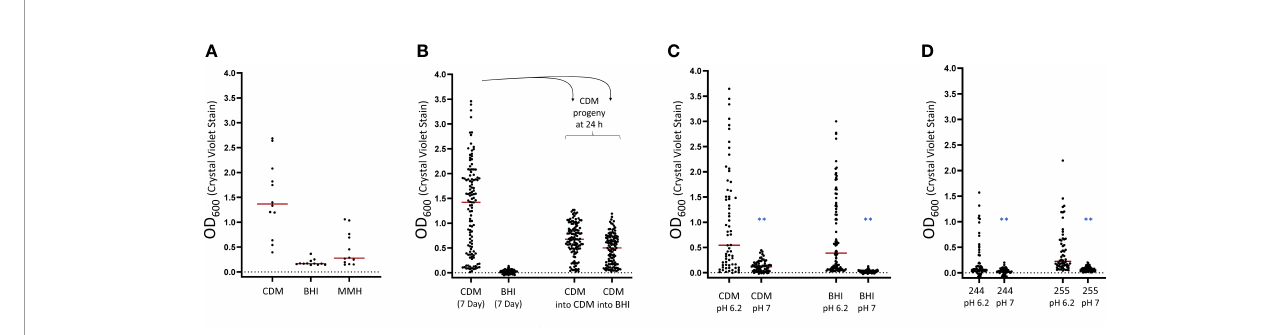
FIGURE 4 | pH of the culture medium impacts the ability of F. tularensis to form bio fi lm. (A) LVS bio fi lm formation was assessed in Chamberlain ’ s de fi ned medium (CDM), brain-heart infusion broth (BHI) supplemented with 1% IsoVitaleX and modi fi ed Mueller-Hinton broth (MMH) supplemented with 2% IsoVitaleX. Bio fi lms were assayed at 10 days post-inoculation. (B) LVS grown in either CDM or BHI for 7 days was sub-cultured via replica plating into CDM or BHI. (C) LVS bio fi lm formation was assessed after culturing for 7 days in CDM or BHI pH adjusted to 6.2 or 7. (D) The effect of culture medium pH was assessed in fully virulent Type A and B isolates (FRAN 244 and FRAN255, respectively). The red bar indicates the median value after at least 3 independent experiments. ** P